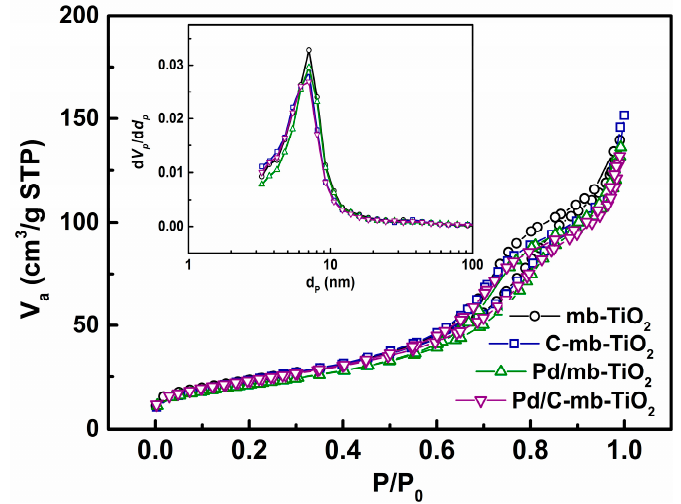
Figure 1. ( a ) XRD pattern and ( b ) Raman spectra of the samples. ( □ anatase, ● TiO 2 (B)).